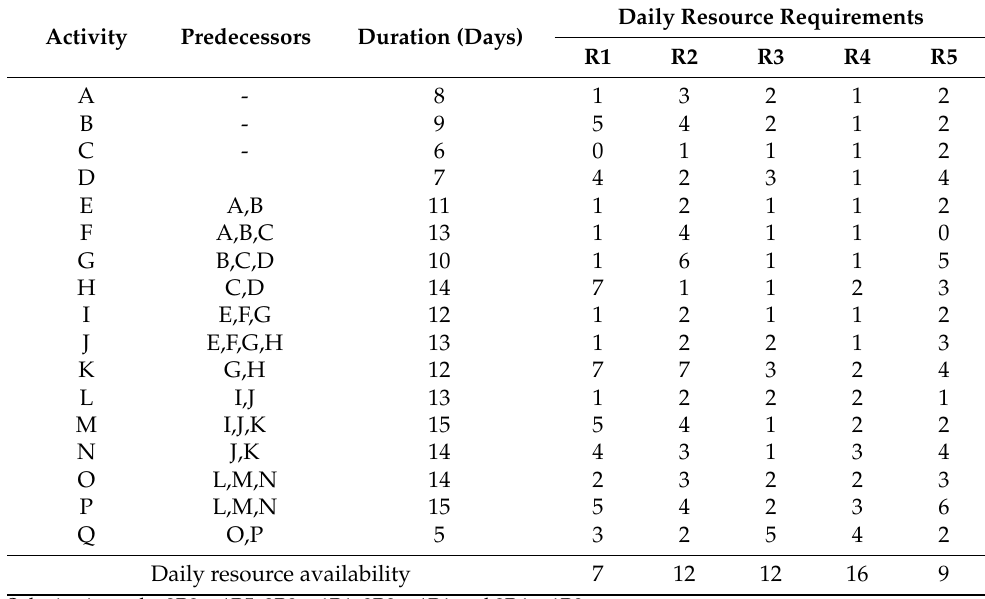
Figure 3. Network Diagram for Project B.